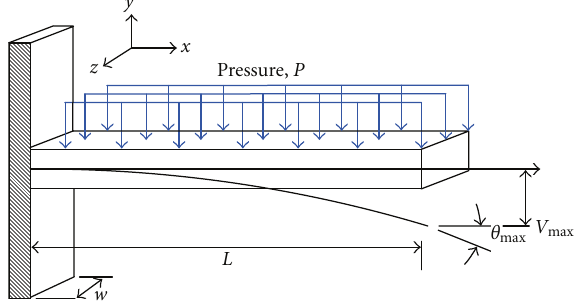
Figure 2: Load distribution and the cantilever bending schematic